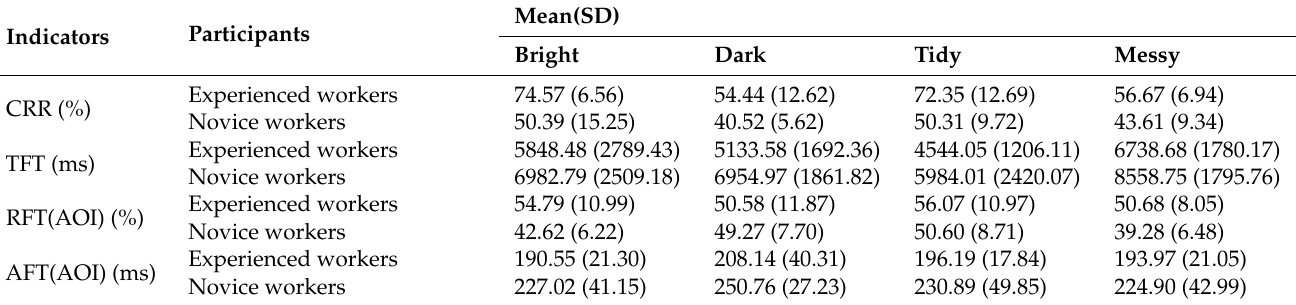
Table 3. Correct recognition rate, total fixation time, AOI fixation time ratio, and average AOI fixation time for experts and novices in scenes of various environmental